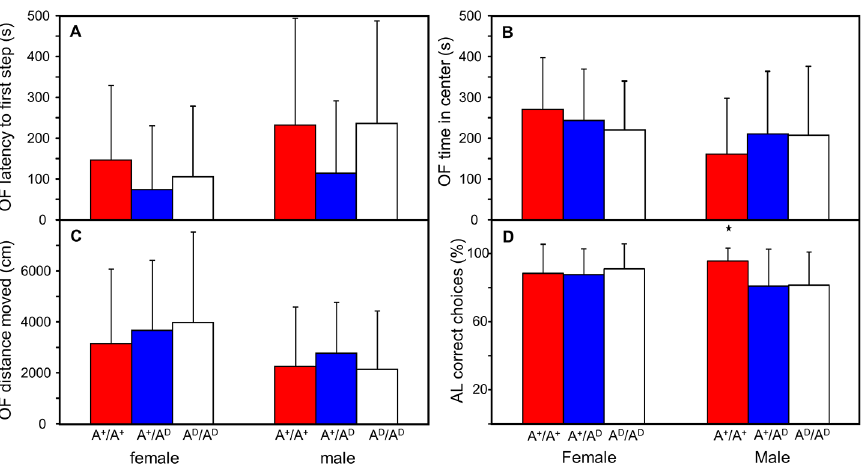
Figure 3. Behavioral variables in Open Field (OF) and Associative Learning (AL) tests. A) Latency (s) to first step in OF test. B) Total time spent in the center of the arena (s) in OF test. C) Distance moved (cm) in OF test. D)) Correct choices (%) in AL test. Data shown as mean and standard deviation.